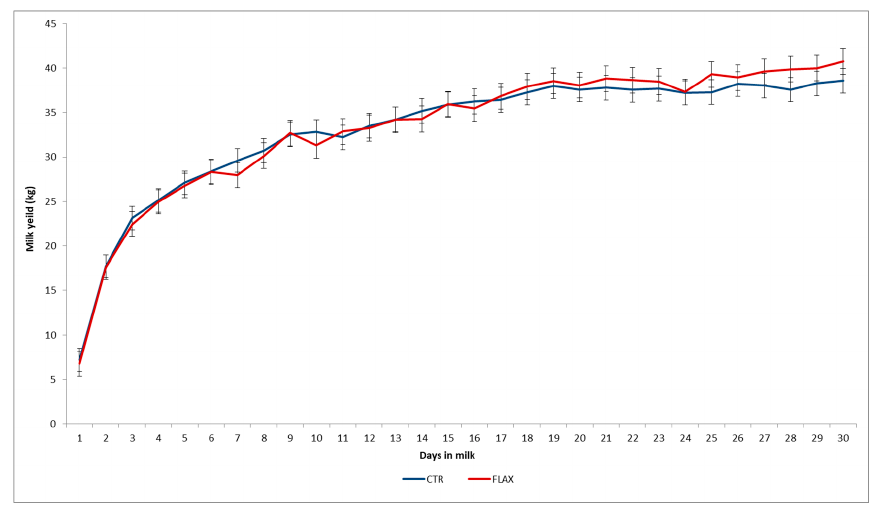
Figure 1. Least square means for control (CTR; solid line) and flaxseed supplemented (FLAX; dotted line) diets on the early and commercial milk production of Holstein cows during the first 30 d of the subsequent